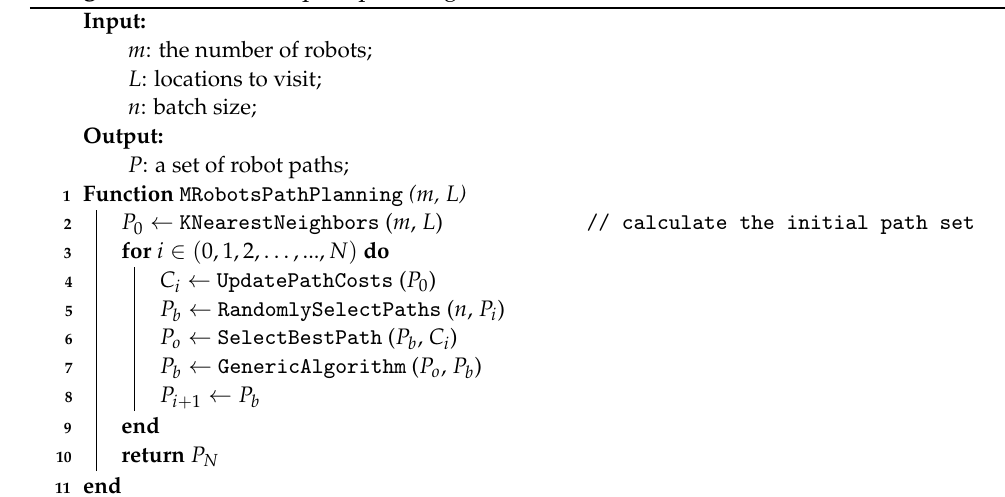
Algorithm 4: M-robot path